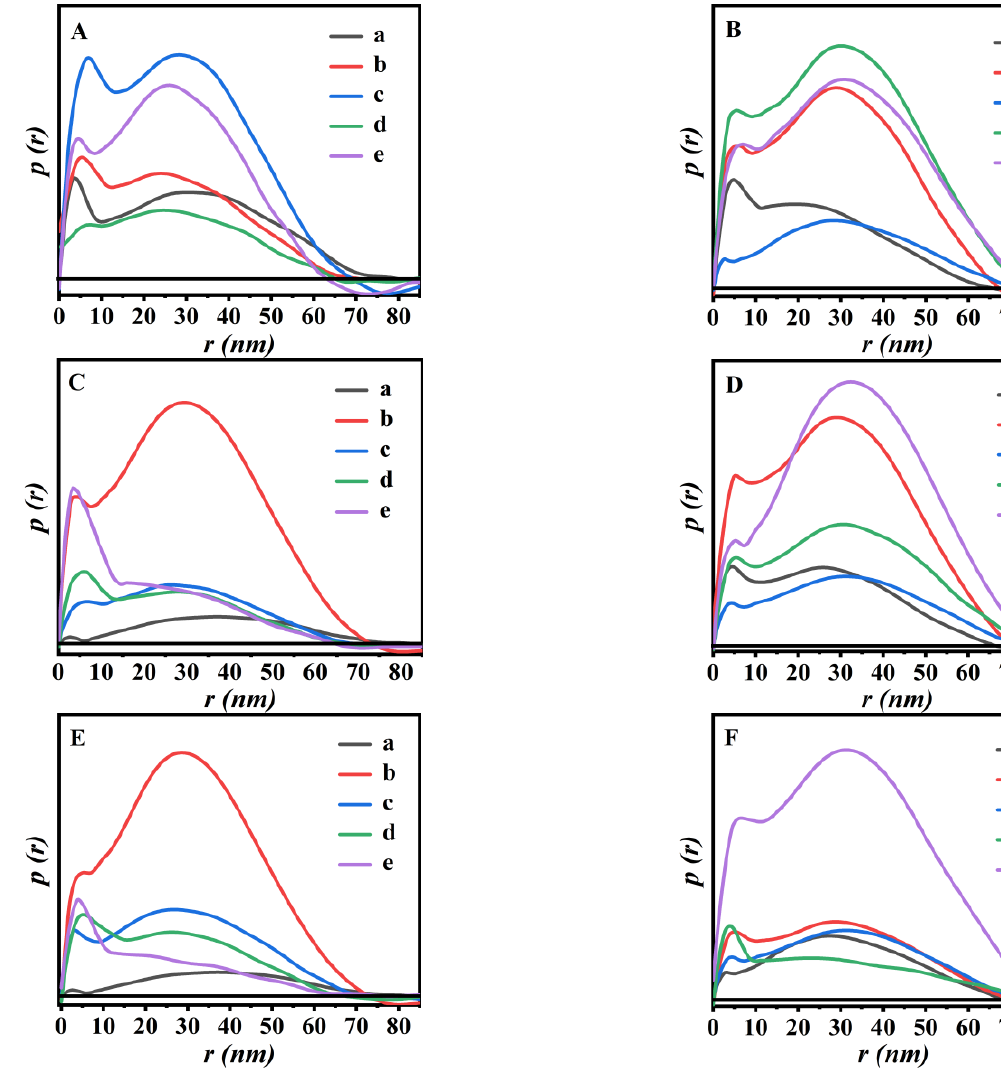
Figure 7. PDDF profiles of the swollen/shrunken P(NA- AA)−0−0.1 ( A , D ), P(NA- AA)−0−1 ( B , E ), and P(NA- AA)−0−10 ( C , F ) under pH 7.4 ( A , B, and C ) and 2.0 ( D , E, and F ) with the extended time. (a) 1 h, (b) 3 h, (c) 5 h, (d) 8 h, and (e) 24 h.